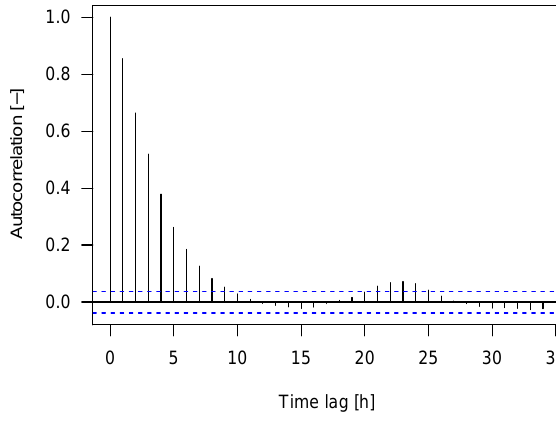
Figure 12. WRF forecasted rainfall autocorrelation at the catchment outlet calculated for the calibration and validation period. Horizontal blue lines indicate the autocorrelation significance